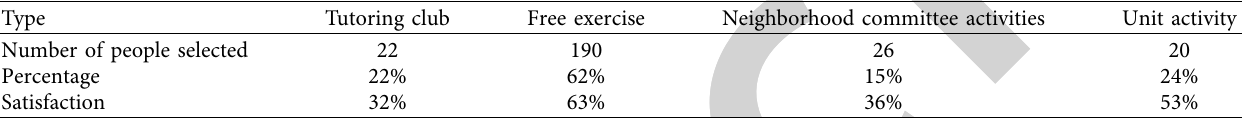
Table 4: Exercise and fitness methods for the elderly in urban communities ( n � 210).